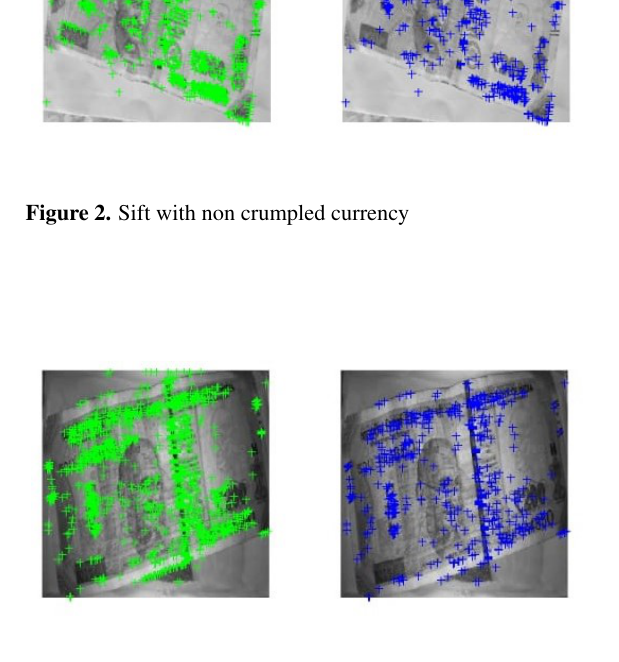
Figure 3. Sift with crumpled currency